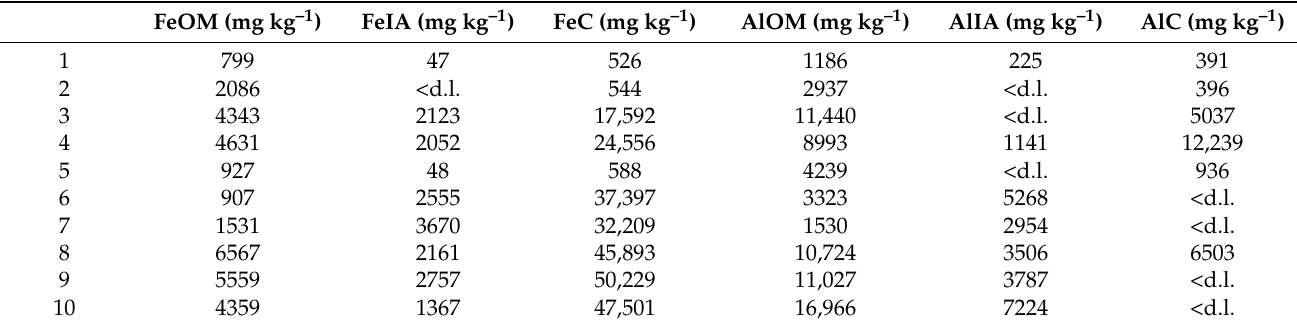
Table 2. Summary of other soil properties considered in this